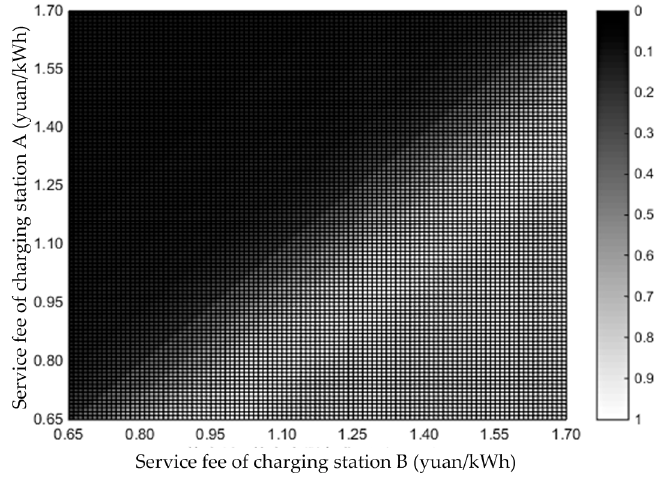
Figure 5. Expected value of charging balance in different charging service fees.